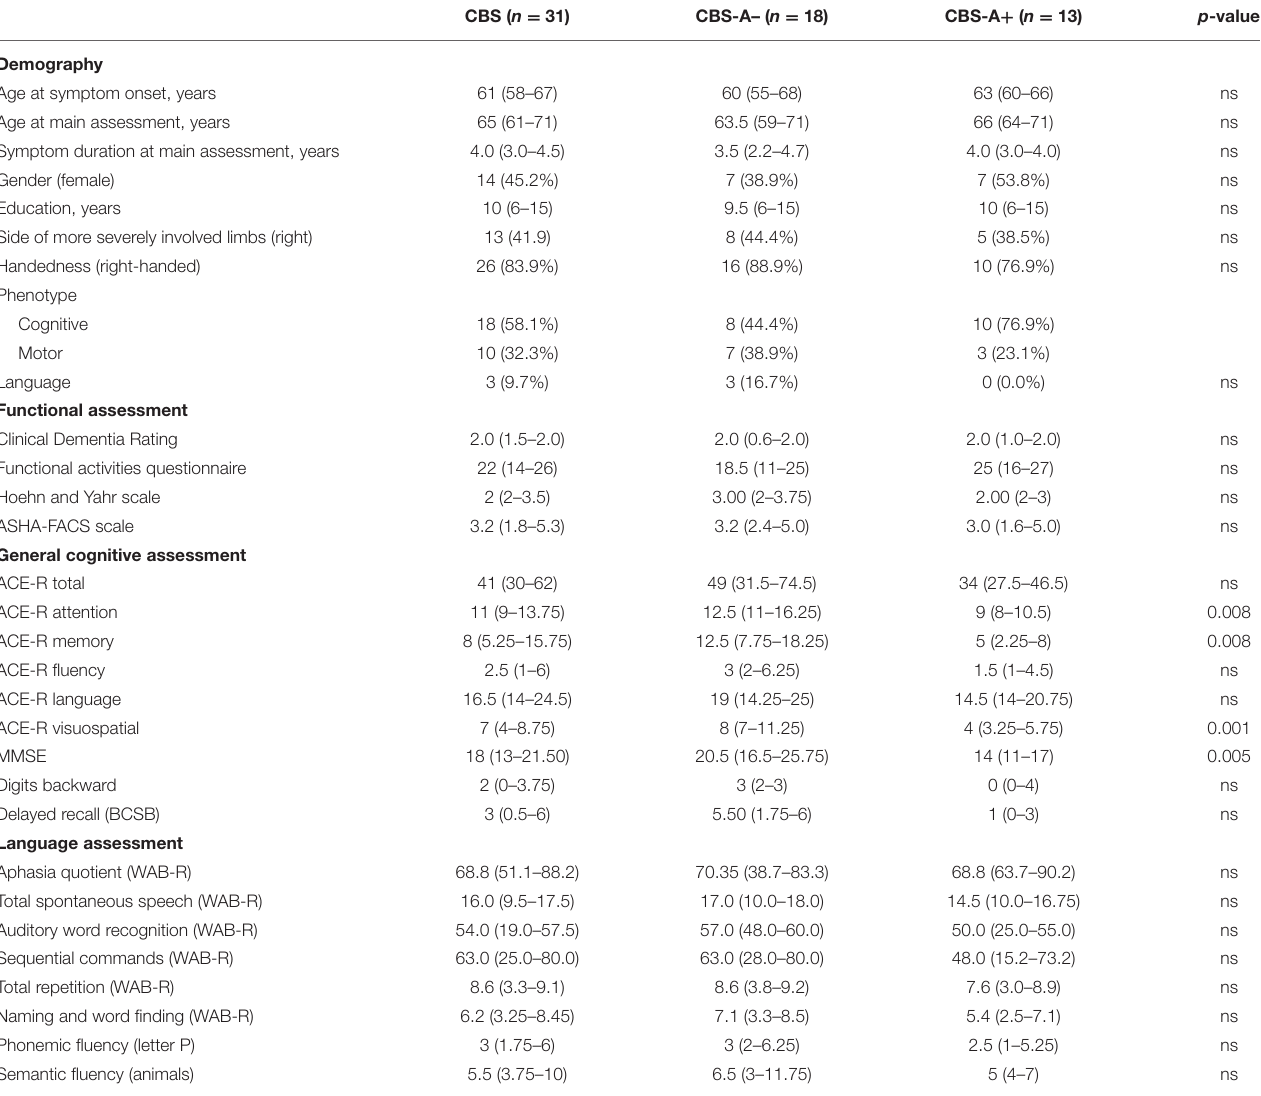
TABLE 1 | Demography, functional, cognitive, and language assessment of patients with CBS and comparison by amyloid-PET